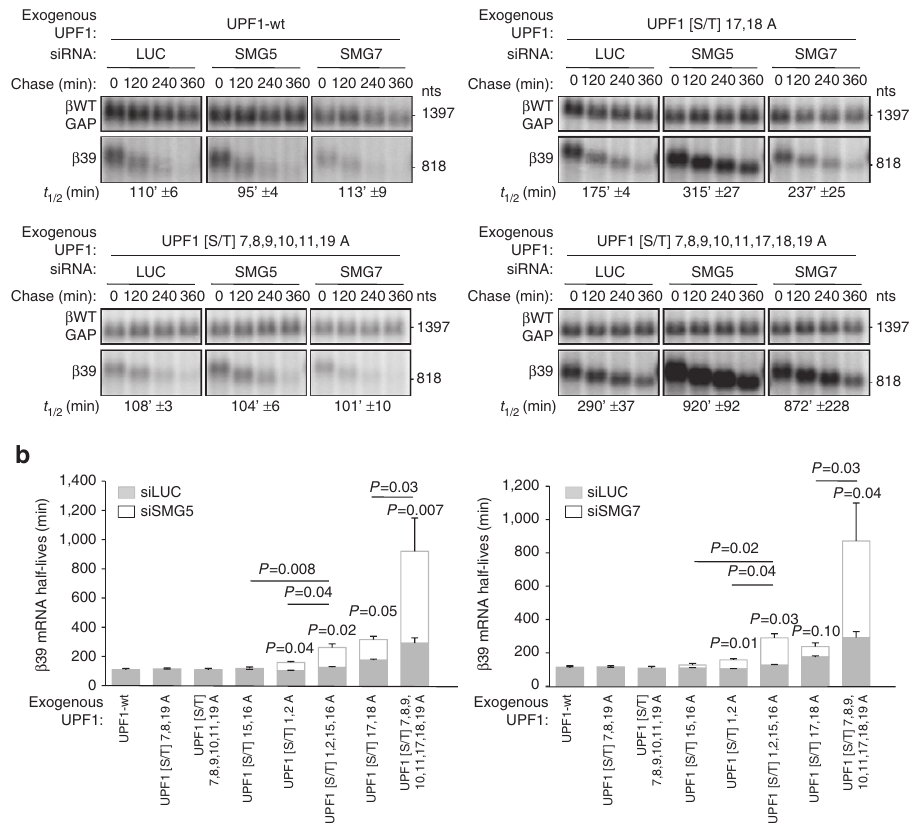
Figure 6 | UPF1 hyperphosphorylation compensates for SMG5 and SMG7 depletion. ( a ) Northern blots showing the decay of b 39 mRNA in HeLa Tet-Off cells depleted for endogenous UPF1 and expressing the indicated exogenous variants of UPF1. In addition, cells were treated with siRNAs targeting SMG5 or SMG7, or as a control, Firefly Luciferase (LUC). Numbers above the panels refer to minutes after tetracycline-mediated transcriptional shutoff of b 39 mRNA (chase). b 39 mRNA half-lives ( t 1/2 ) were calculated from three independent experiments as described for Fig. 4b. Numbers on the right refer to RNA lengths in nucleotides (nts) excluding polyA-tails. ( b ) Graphs showing b 39 mRNA half-lives calculated from mRNA decay assays presented in a and Supplementary Fig. 6a. Graphs compare siLUC control conditions (grey) to siSMG5 (white; left graph) or siSMG7 conditions (white; right graph). Error bars represent s.e.m. from three independent experiments. P values indicated above bars compare siSMG7 and siSMG5 conditions to control siLUC. P values indicated above brackets compare siSMG7 and siSMG5 conditions between different UPF1 mutants (all P values were calculated using the paired two-tailed Student’s t